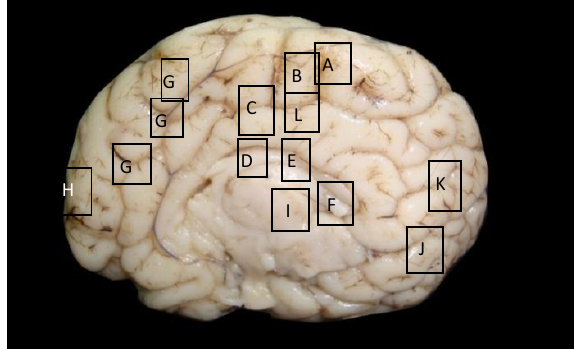
Figure, 1: Morphometry of cerebral cortex of age 28 day neonate indicate, A: Central sulcus, B: Paracentral lobule, C: Cingulate sulcus, D: Lateral ventricle, E: Corpus callosum, F: Fornix, G: Medial frontal gyrus, H: Frontal lobe, I: Thalamus, J: Calcarine sulcus, K: Parieto-occipital sulcus, L: Cingulate gyrus.